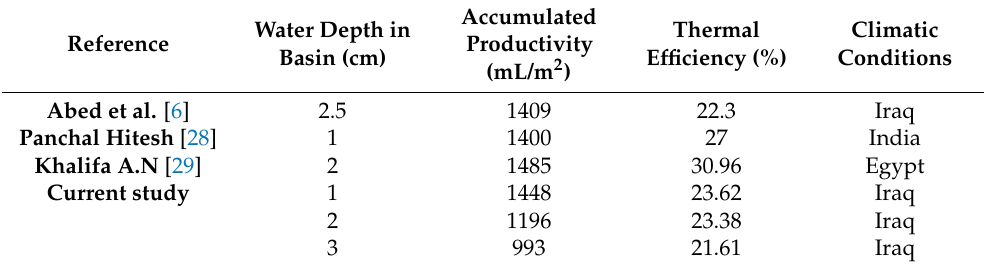
Table 2. Comparison with similar distillation systems.